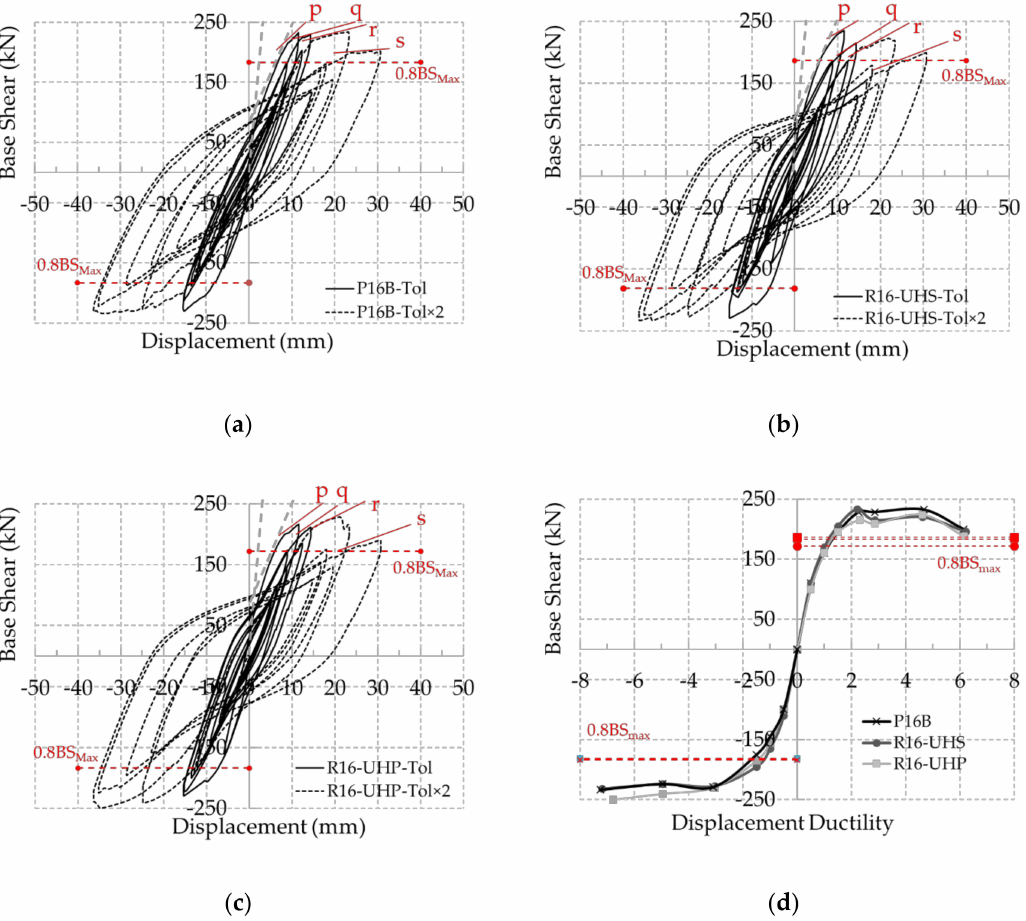
Figure 11. Experimental hysteretic response of: ( a ) the As-built column (P16B); ( b ) the repaired column by concrete jacket with steel fiber (R16-UHS); ( c ) the repaired column by concrete jacket with polymer fiber (R16-UHP) during the tests Tol and Tol × 2; ( d ) Experimental envelope curve for each tested